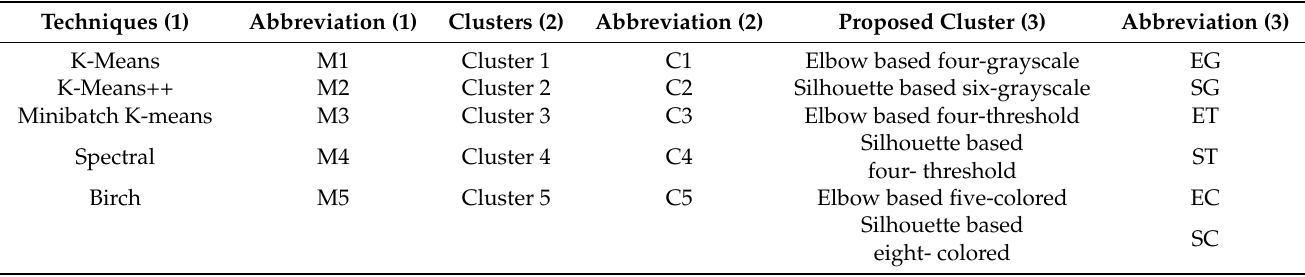
Table 3. Proposed unsupervised techniques in our